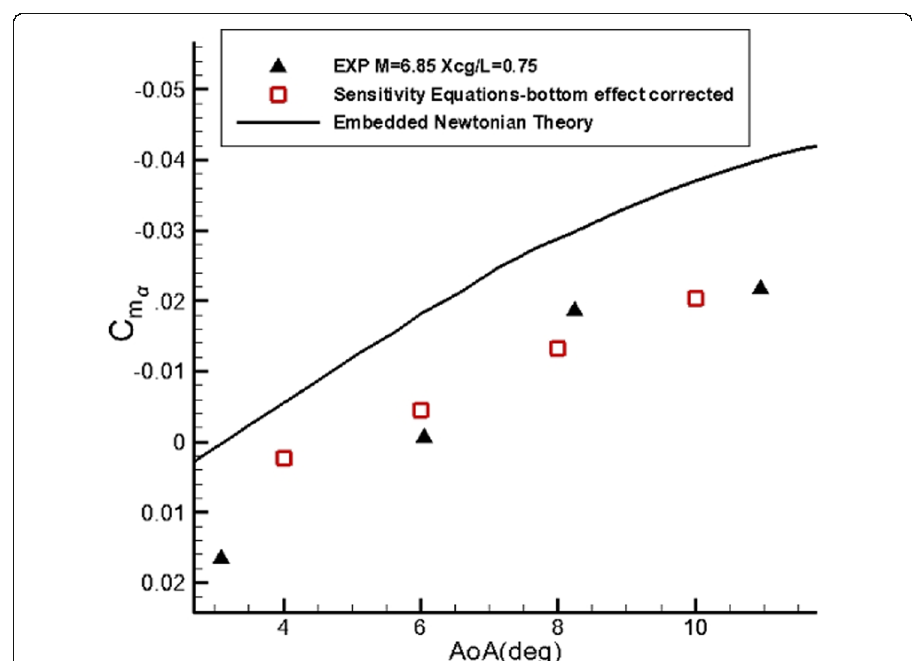
Fig. 9 Comparison of the static moment derivative between theoretical, experimental and numerical results after considering the bottom effect